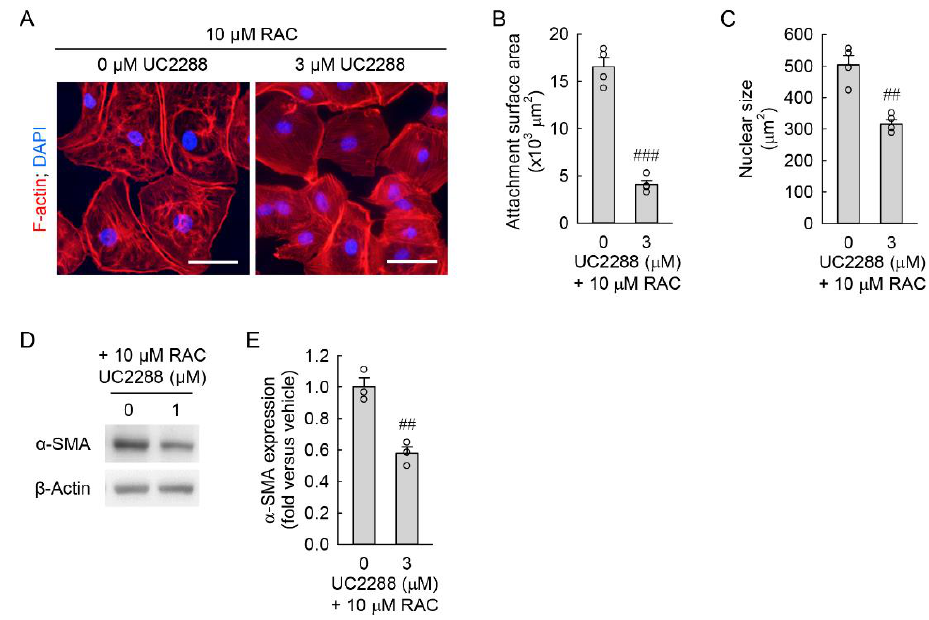
Figure 5. Inhibition of p21 reduces cellular hypertrophy and myofibroblast transformation induced by repeated administration of cisplatin (RAC). Normal rat kidney fibroblast NRK-49F cells were treated with 0, 1, or 3 µ M UC2288, a cell-permeable p21 inhibitor, in 0.1% dimethyl sulfoxide and 10 µ M cisplatin in normal culture media for 6 h, and the media were replaced with normal culture media, followed by incubation for 18 h. The experiment was repeated three times, and finally, the cells were harvested at 72 h after the first treatment. ( A ) Representative images of F-actin-stained cells at × 400 magnification using the Nikon Eclipse Ni upright microscope (Nikon, Tokyo, Japan), DS-Ri2 camera (Nikon), and NIS-Elements imaging software (Nikon). Total cellular DNA was stained with 4′ ,6-diamidino-2-phenylindole (DAPI). Scale bar, 50 μm. ( B , C ) Quantification of cell attachment surface area from F-actin staining and cell nuclear size from 4′ ,6-diamidino-2-phenylindole staining at × 200 magnification using NIS-Elements imaging software (Nikon, Tokyo, Japan) ( n = 4 experi- ments). ( D ) Representative Western blot of α -smooth muscle actin ( α -SMA) expression. Anti- β -actin antibody was used as a loading control of Western blot analysis. ( E ) Quantification of α -SMA ex- pression using the Azure c300 imaging system ( n = 4 experiments). ( B , C , E ) Data are presented as mean ± standard error of the mean with individual data points. Statistical significance was deter- mined by ANOVA followed by Tukey’s post hoc test (( B ) F 1,6 = 134.557, p < 0.001; ( C ) F 1,6 = 31.504, p = 0.001; ( E ) F 1,4 = 34.633, p = 0.004). ## p < 0.01, ### p < 0.001 versus 0 µ M